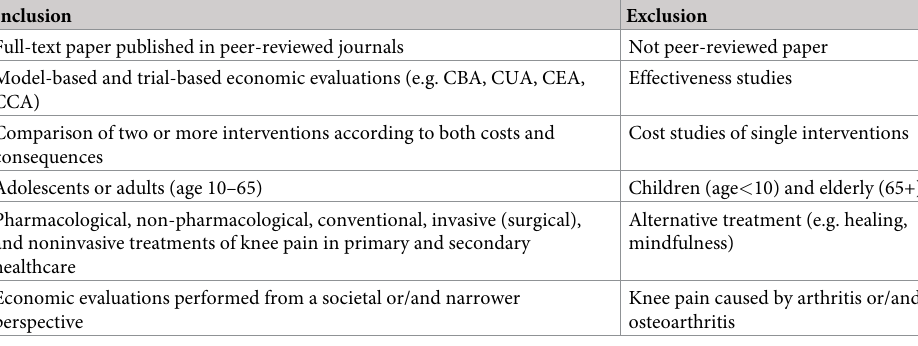
Table 1. Inclusion and exclusion